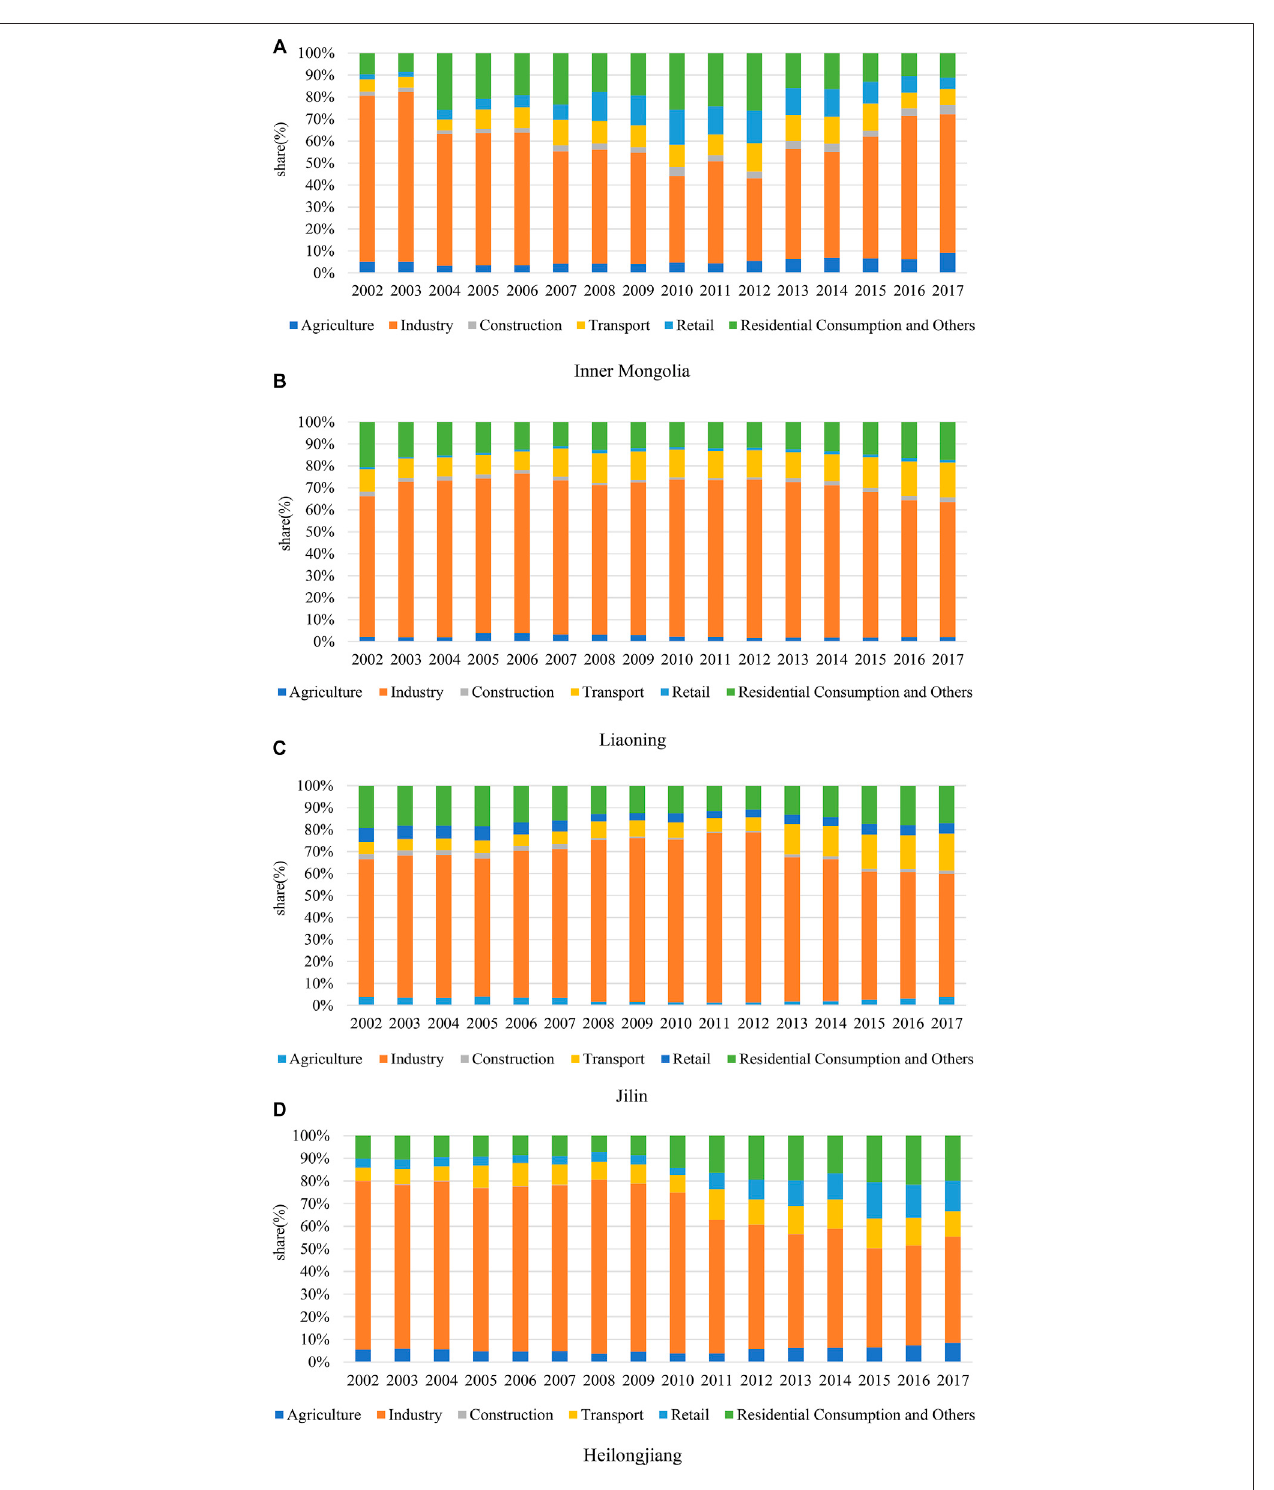
FIGURE 3 | Share of CO 2 emissions from the different sectors in (A) (Inner Mongolia), (B) (Liaoning), (C) (Jilin) and (D) (Heilongjiang).